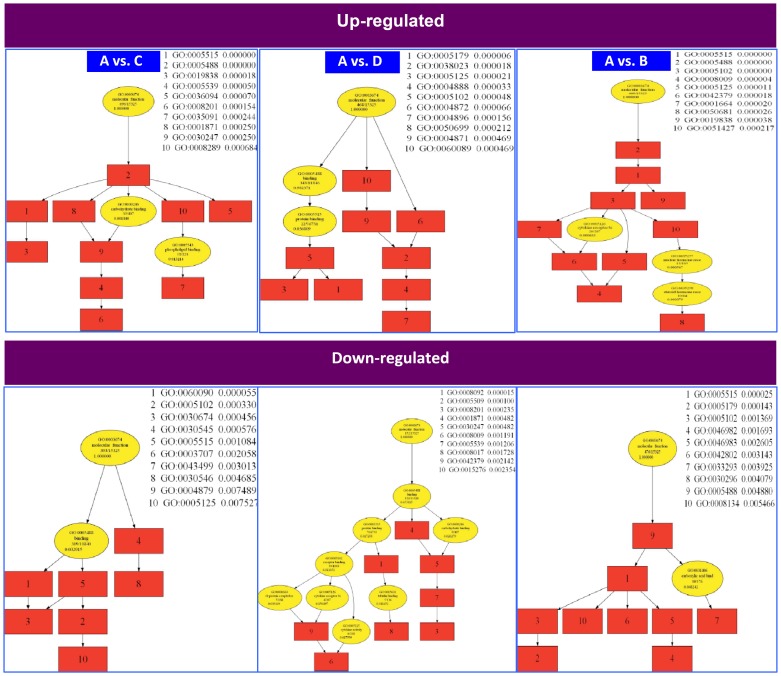
GO molecular functional annotations.Functional relationship presented with GO “trees” for the top 10 (p<0.005) GO annotations (Table 3) is shown for both up- and down-regulated A vs. B, A vs. C, and A vs. D. The red color labels indicate the top 10 GOs. The yellow colors show GOs with lower p value, which were not presented in Table 3 but could be identified from the differentially expressed lncRNAs in PPROM, FT, PRTB, and PROM.